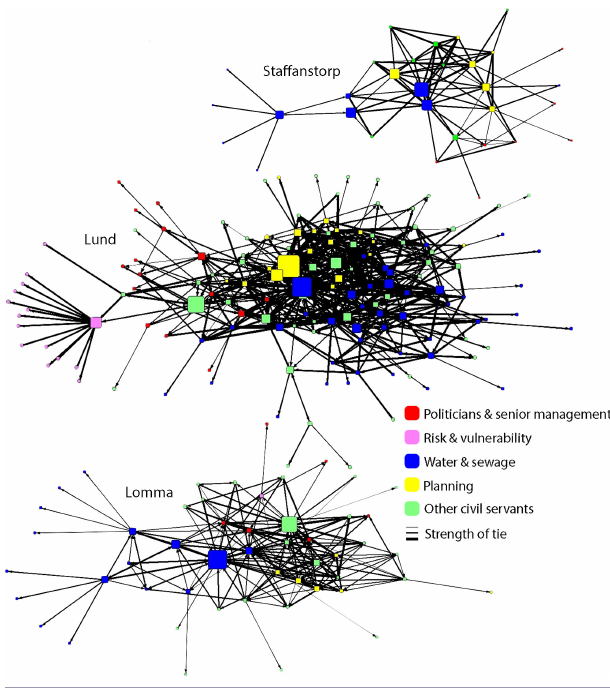
Fig. 4 . Influence over influential actor in networks mitigating flood risk within the three studied municipal administrations. Node size = influence over influential actors (in-eigenvector centrality). Tie thickness = normalized sum of importance of inputs. Note that node sizes and tie thicknesses are relative within each network and cannot be compared between